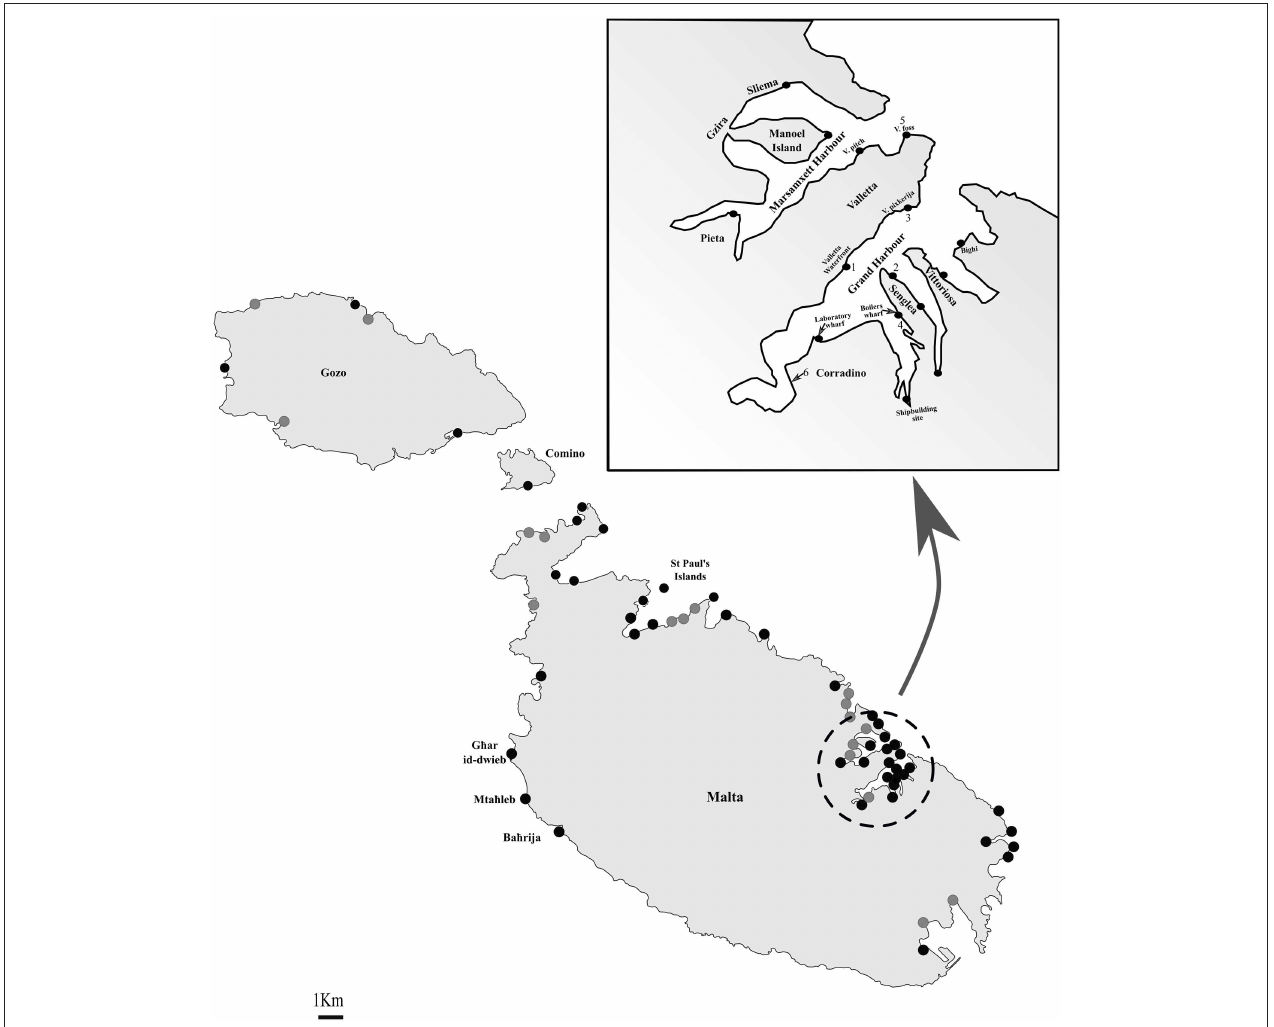
FIGURE 1 | Map of the Maltese islands showing locations where catches were documented. Enlarged area shows competition locations in the Grand Harbor and Marsamxett harbor areas. Black dots denote fishing competitions; gray dots denote locations fished only by hobby fishers; numbers denote locations where non-native species were caught by both sport and hobby fishers. G¯nar id-dwieb, Mta¯nleb, and Ba¯nrija are cliff fishing sites.